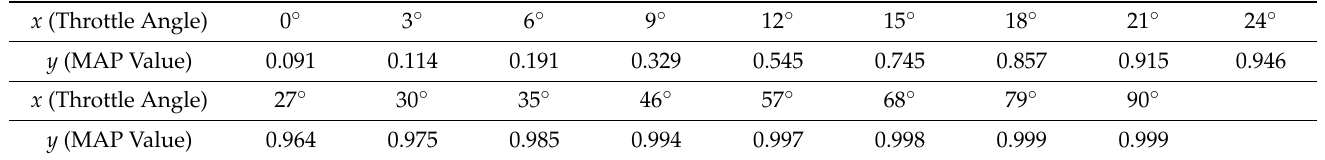
Table 2. Throttle angle ( x ) and MAP values ( y ) at 300 r/min [27].